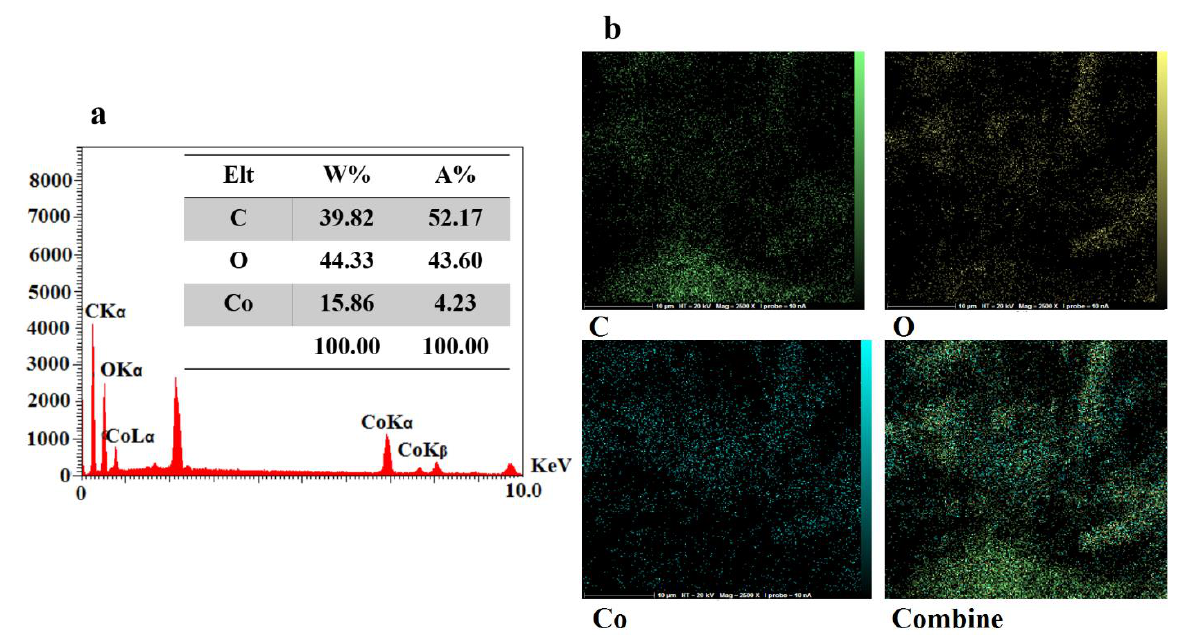
Figure 3. FE-SEM images of the CoMOF in ( a ) 500 nm and ( b ) 2 µM.